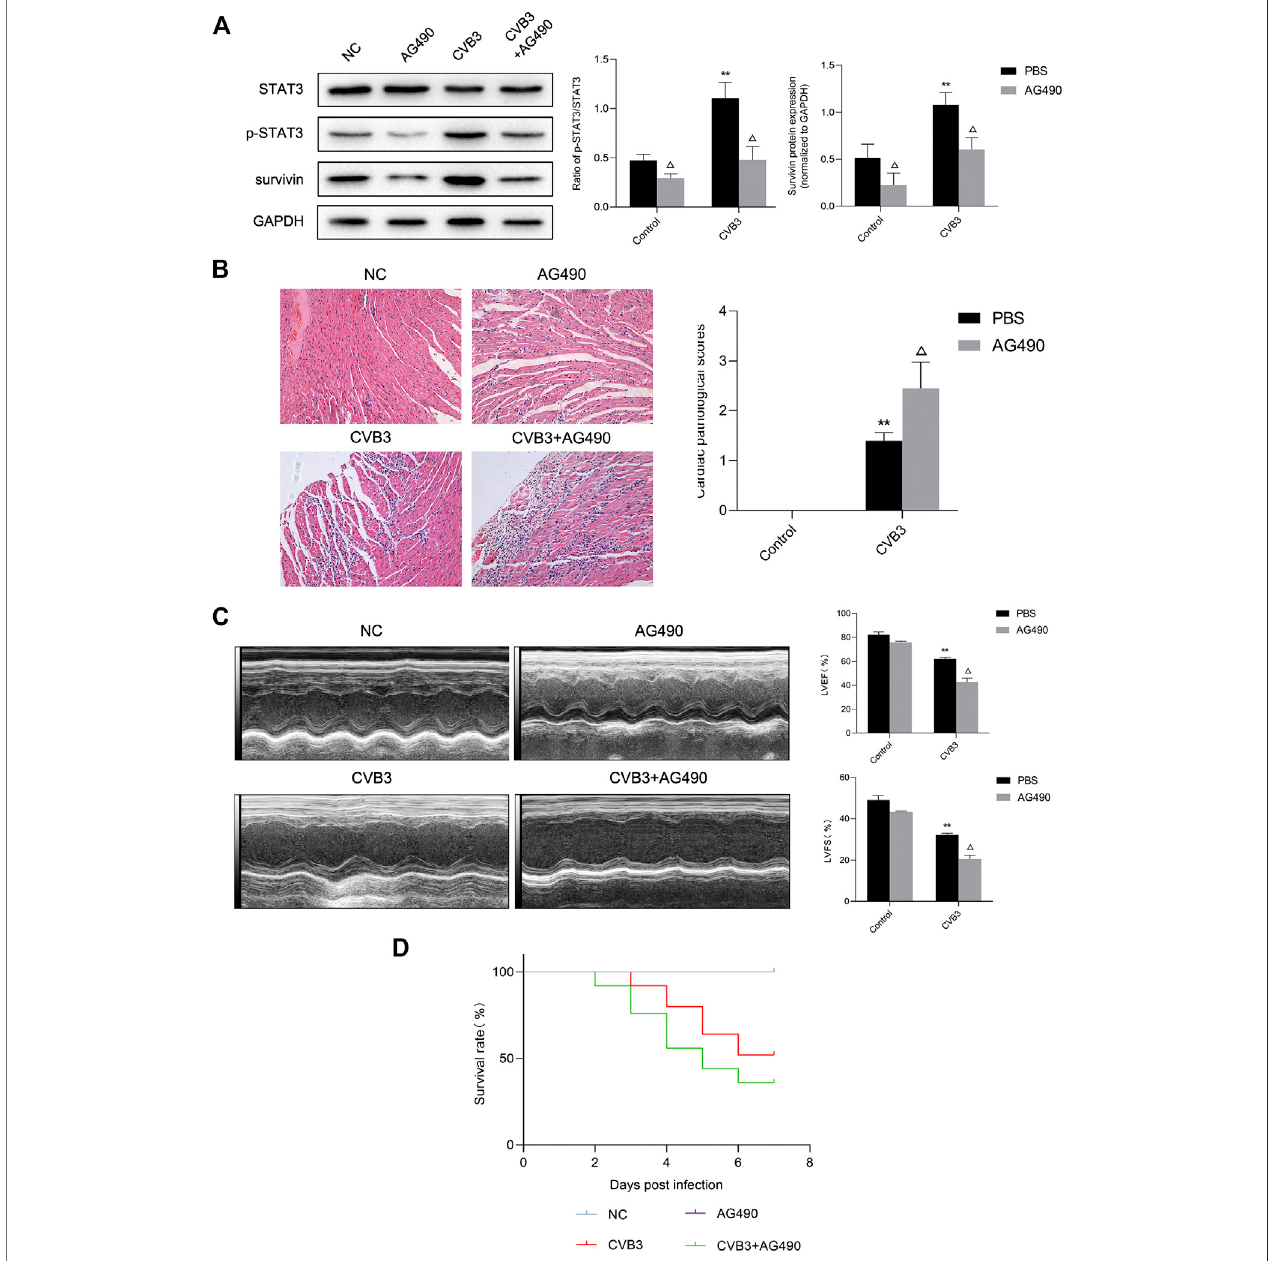
FIGURE 3 | Protective effect of activated STAT3 in the viral myocarditis (A) The related proteins were measured by western blot ( n (cid:2) 4). ** p < 0.01 vs control groups(NCandAG490group), △ p < 0.05vsCVB3groups(CVB3andAG490+CVB3group) (B) HEstainingofmyocardium( n (cid:2) 4,200 × )andcardiacpathological scores ( n (cid:2) 4) ** p < 0.01vs control groups (NC and AG490 group), △ p < 0.05 vs CVB3 groups (CVB3 and AG490 + CVB3 group) (C) M-mode echocardiogram images and analysis of LVEF and LVFS in different groups ( n (cid:2) 3). ** p < 0.01vs control groups (NC and AG490 group), △ p < 0.05 vs CVB3 groups (CVB3 and AG490 + CVB3 group) (D) Survival analysis of viral myocarditis mice. Survival proportions at day 7 were 100% for the NC group and AG490 group, 52% for the CVB3 group, 36% for the CVB3+AG490 group. ** p < 0.01 vs control groups (NC and AG490 group), △ p < 0.05 vs CVB3 groups (CVB3 and AG490 + CVB3